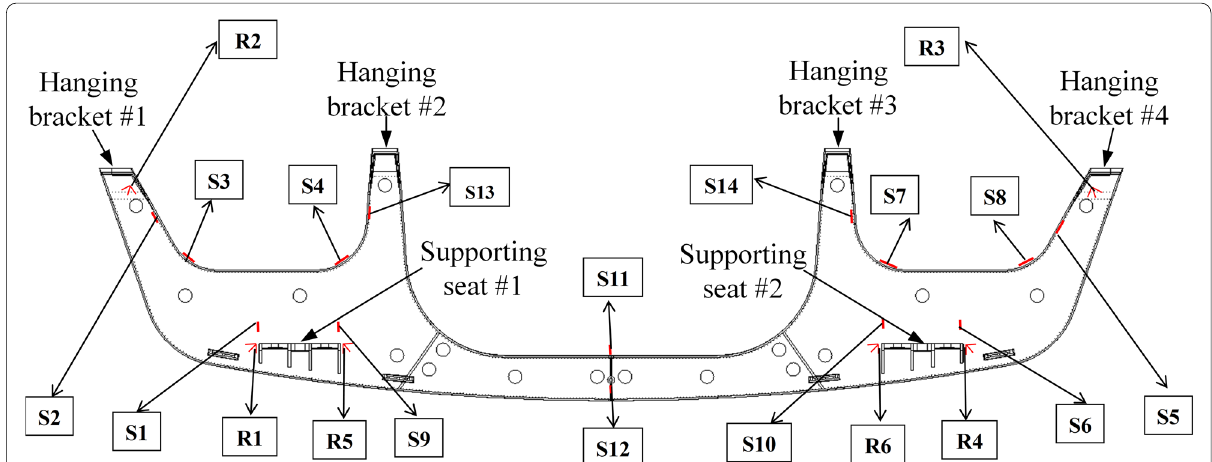
Figure 5 Locations of the installed twenty gauges (R# represents the rosette gauges, S# indicates the normal ones)